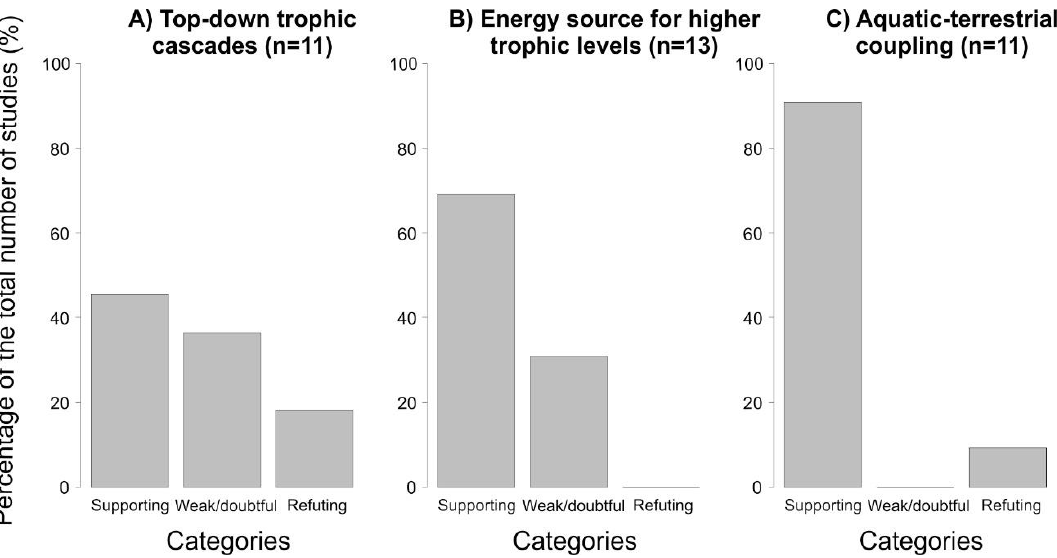
Figure 2. Number of papers supporting or refuting the potential importance of salamanders in aquatic top–down trophic cascades ( A ), energy source for higher trophic levels (i.e., vertical energy flow) ( B ), and energy mobility between freshwater and terrestrial habitats (i.e., lateral energy flow) ( C ). This plot is made according to literature used in each section (Sections 2.2, 3.2 and 4, respectively) of this review. Papers were classified according to three categories: (i) supporting, (ii) weak / doubtful, and (iii) refuting.